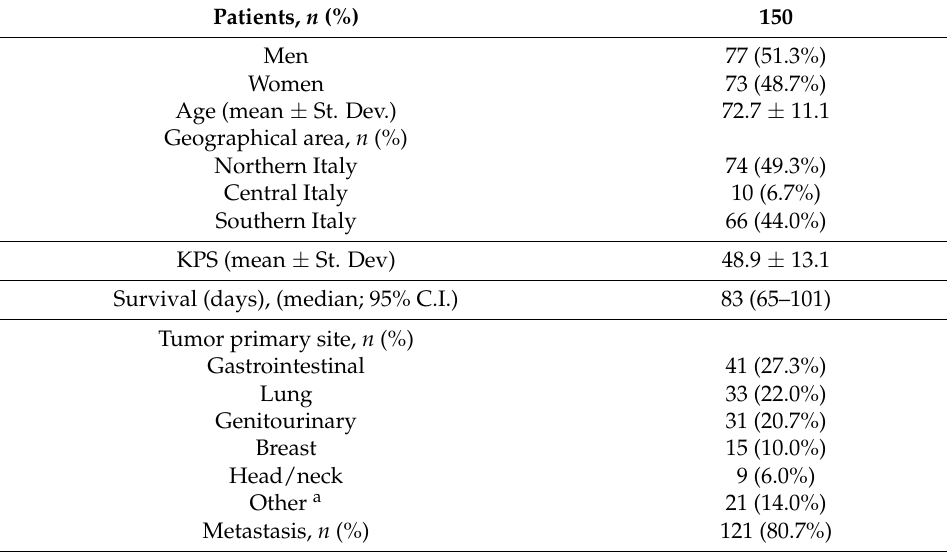
Table 1. Sociodemographic and clinical data of the patients at the